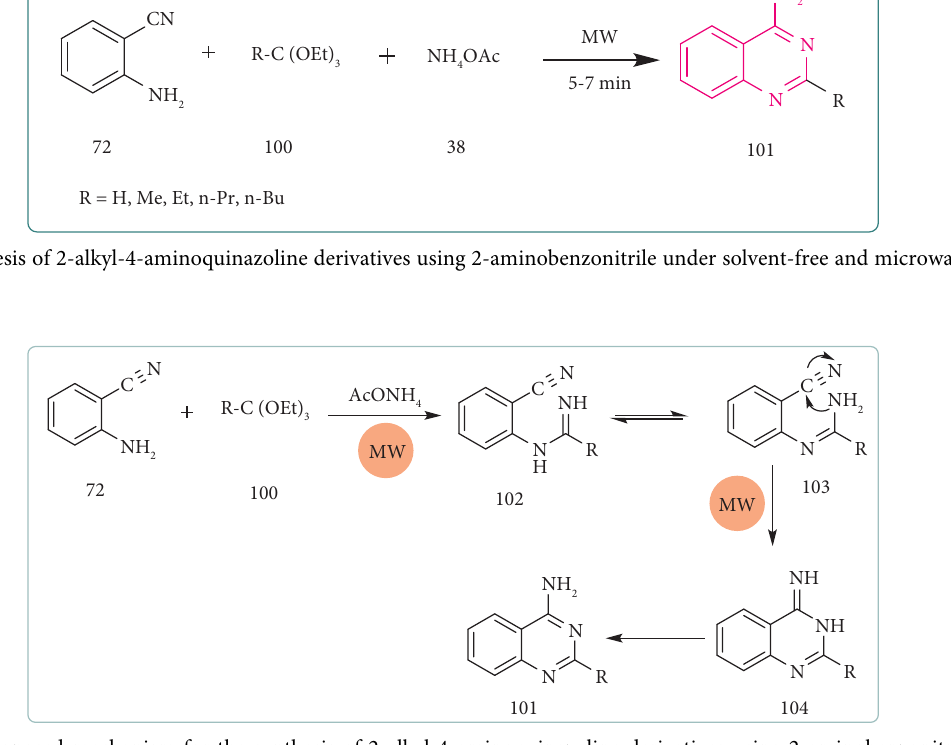
Figure 12: Te proposed mechanism for the synthesis of 2-alkyl-4-aminoquinazoline derivatives using 2-aminobenzonitrile under mi- crowave irradiation